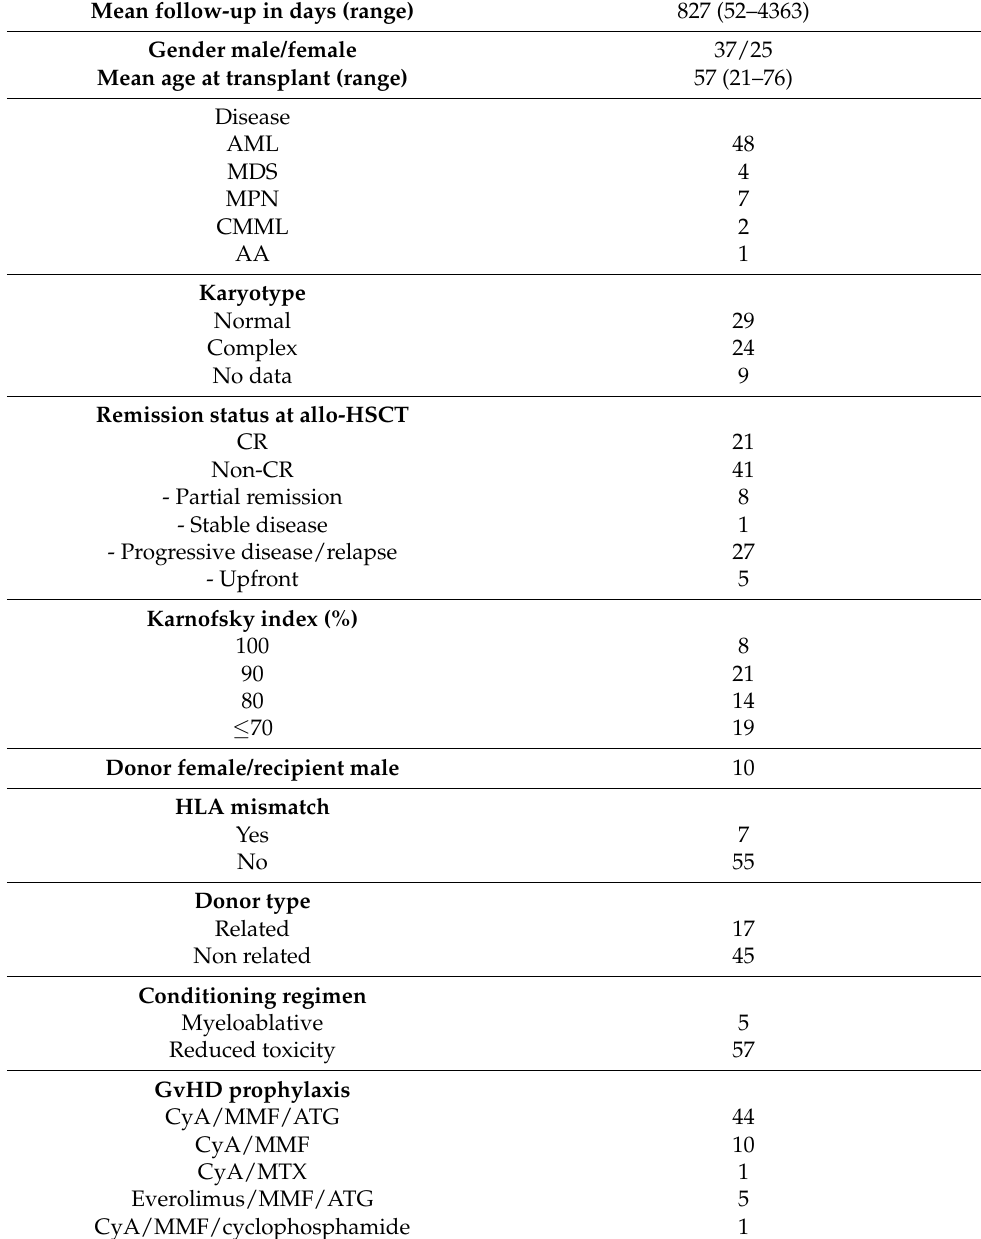
Table 1. Clinical characteristics of patients and